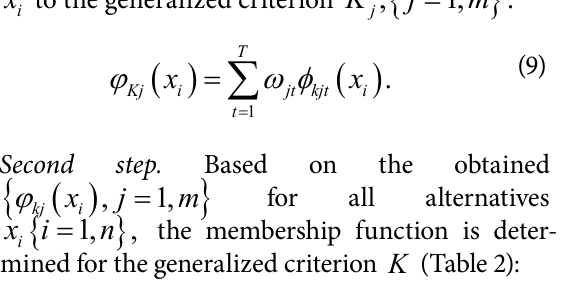
Table 2. Definition of the membership function of alternatives { } 1,